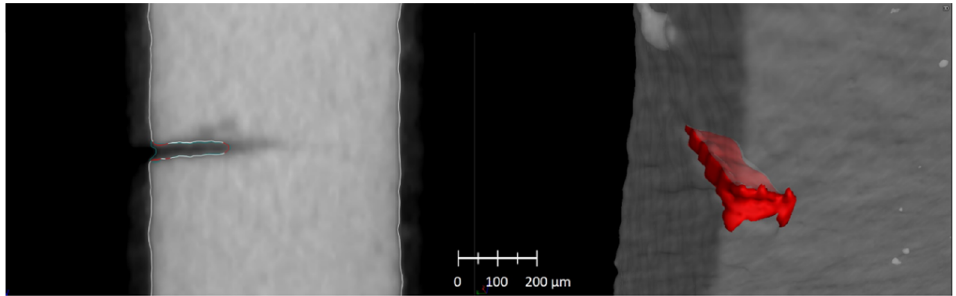
Figure 10. Failure-critical surface defect, marked in red, of an STA heat-treated EB-PBF-manufactured